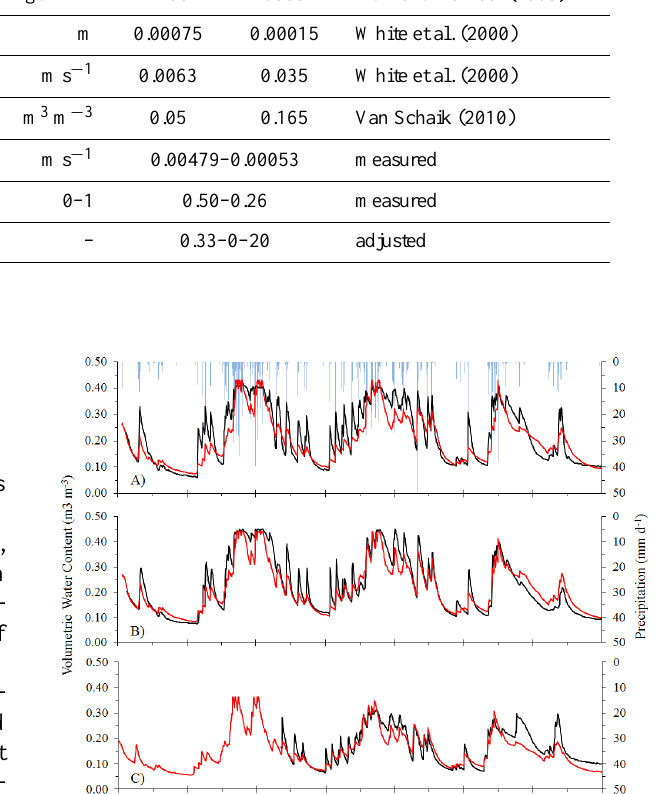
Fig. 3. Observed and simulated soil moisture from March 2009 to September 2012. (A) Site 1; (B) site 2; (C) SMS-3. Black line are measured values, and red line are simulated